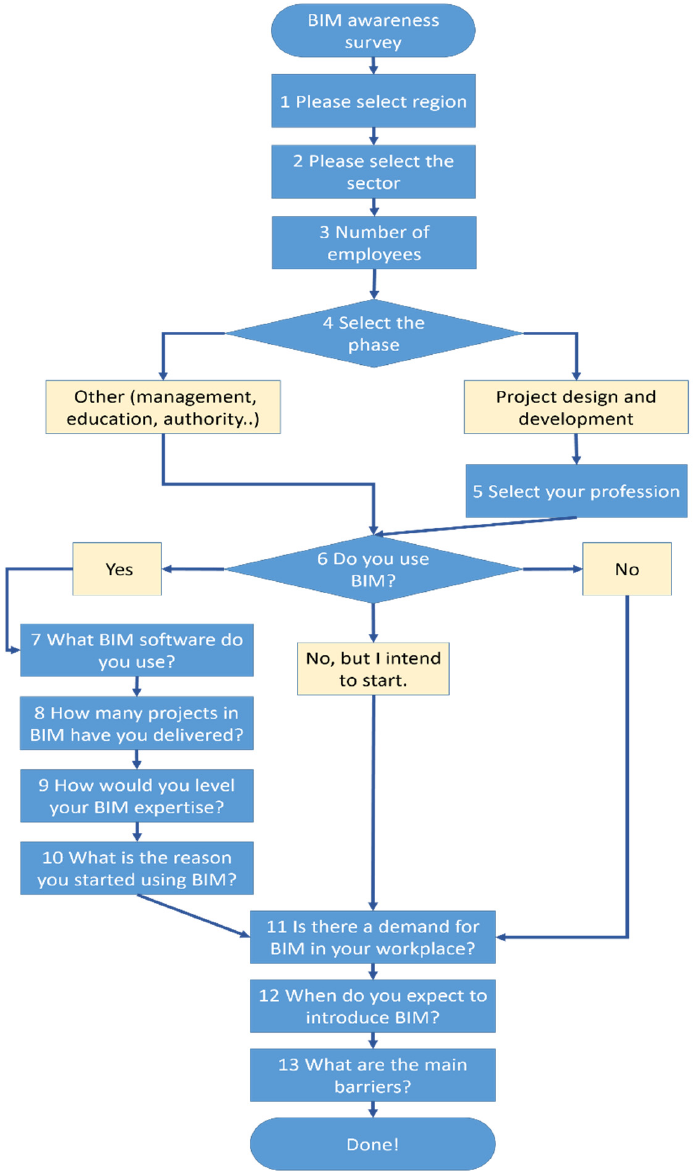
Figure 3. BIM awareness survey logic jumps.